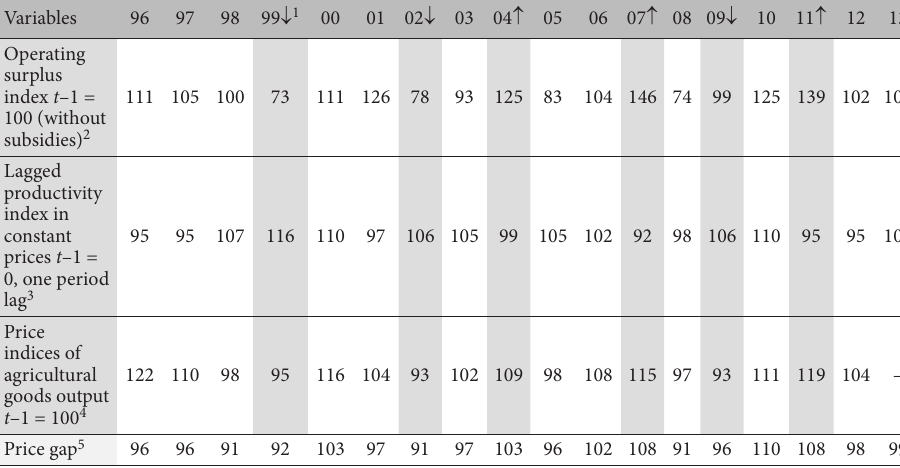
Table 1. Indices of prices, incomes and productivity of factors in Polish agriculture, 1996–2013 Variables